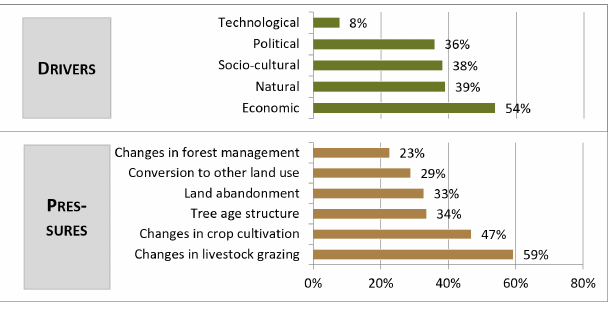
Fig. 6 . Drivers and pressures identified in the